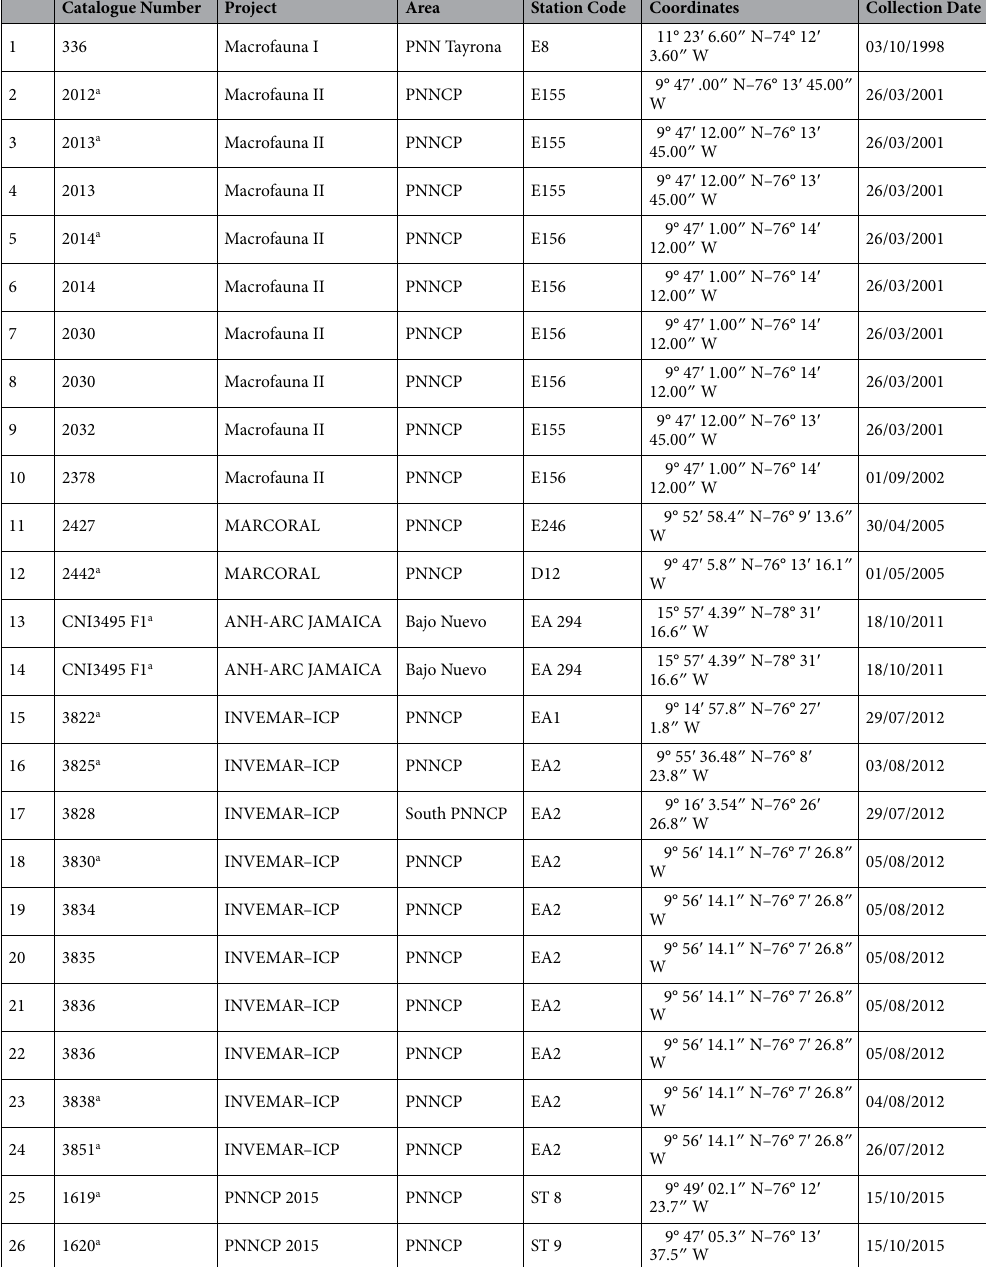
(Table 1). The M. myriaster total DNA sequencing information from Illumina MiSeq sequencing was uploaded to the SRA database (accession ID: PRJNA611988). Primer sequences for the nine confirmed microsatellite loci are available (Table 2) to facilitate future use in research.